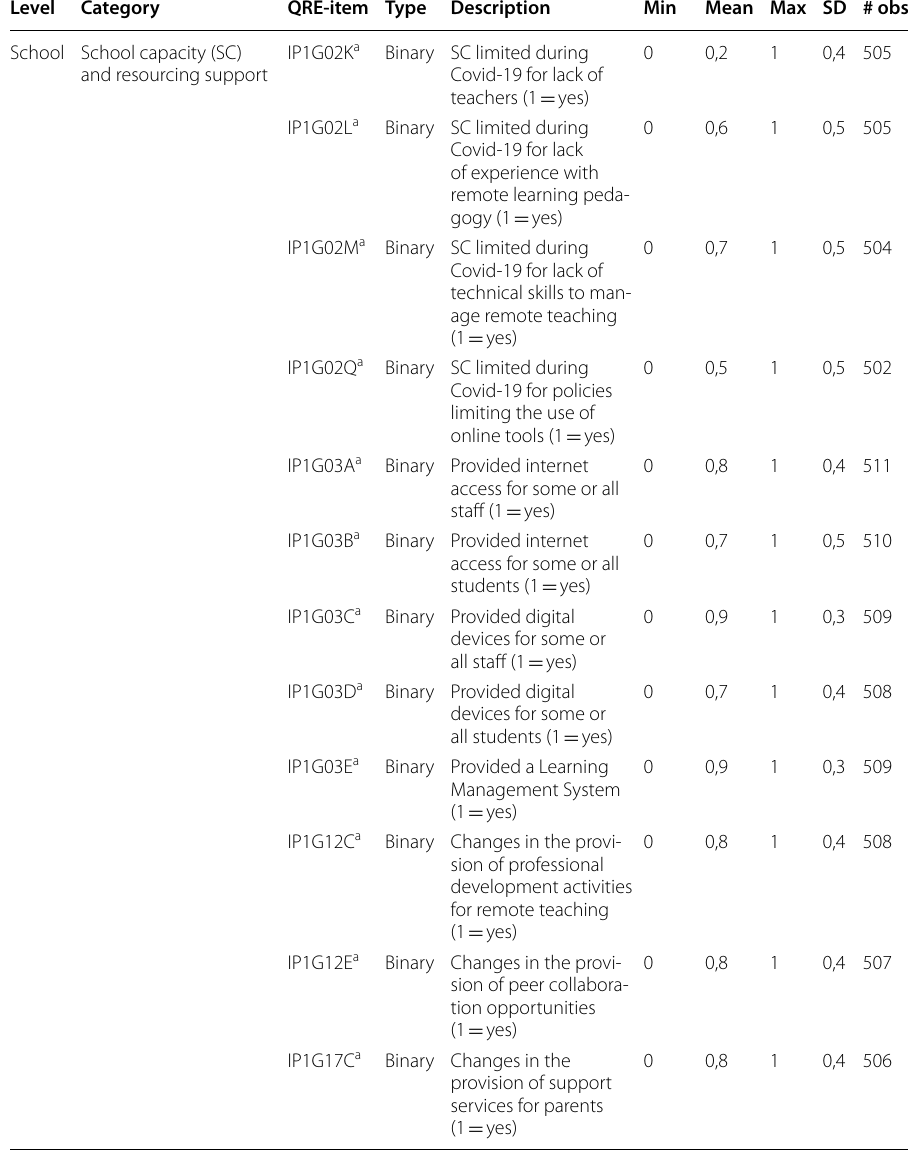
Table 2 REDS questionnaire items on school capacity and resourcing support used to explain the well-being school